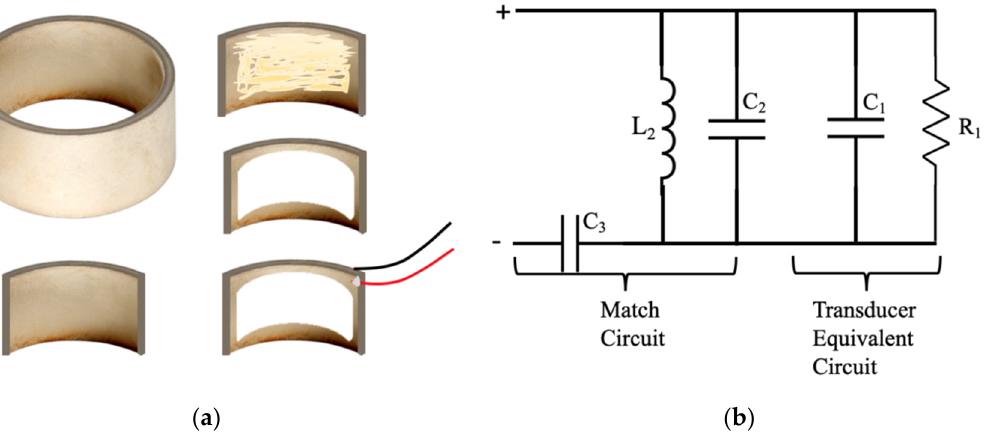
Figure 1. The focused air-coupled transducer: ( a ) Fabrication of the focused air-coupled transducer. ( b ) The equivalent circuit of the focused air-coupled transducer with the electrical impedance matching network.